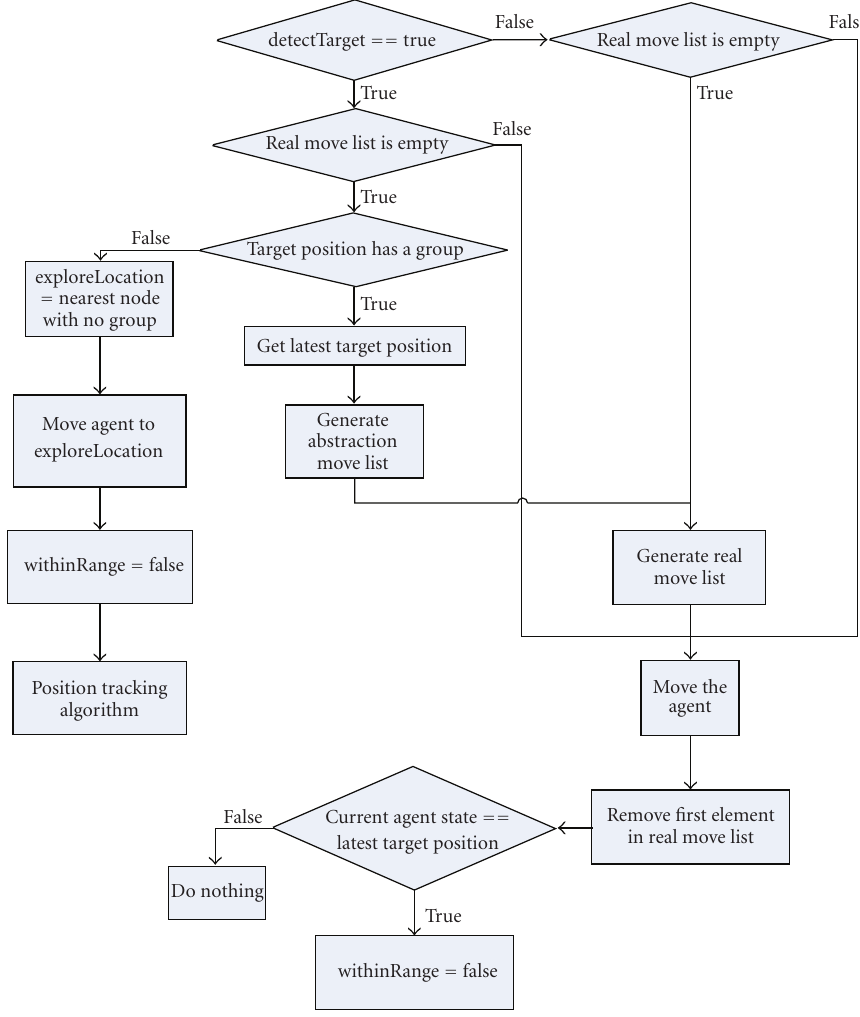
Figure 3: Abstraction MTS